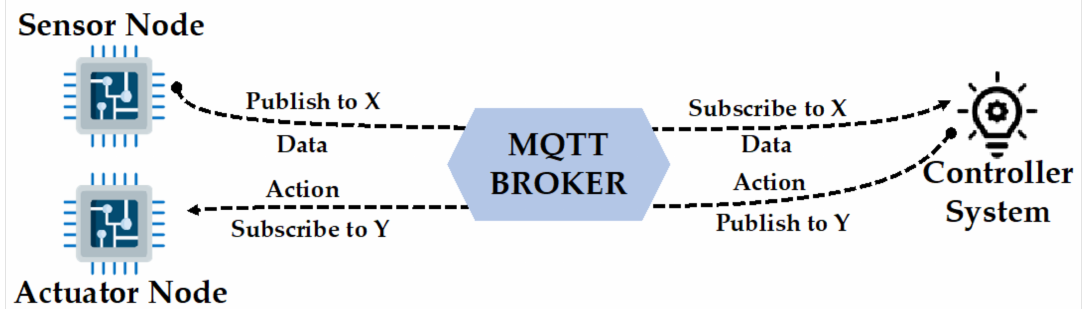
Figure 5. MQTT stream data flow from/to